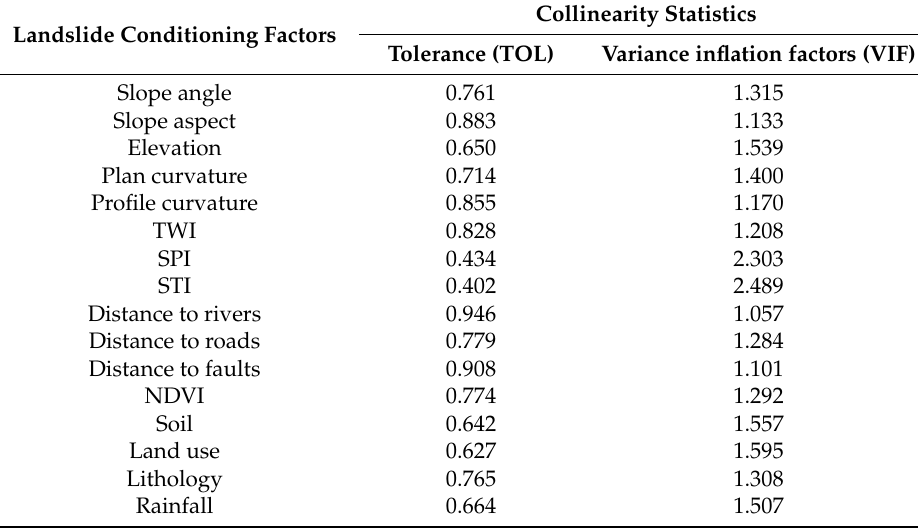
Table 2. Multicollinearity